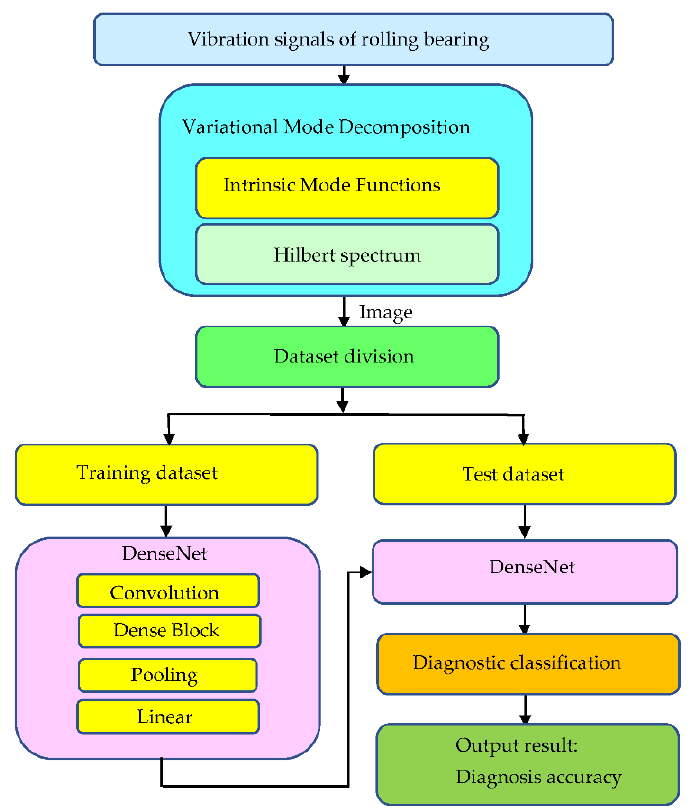
Figure 1. The entire flow chart of VMD-DenseNet.